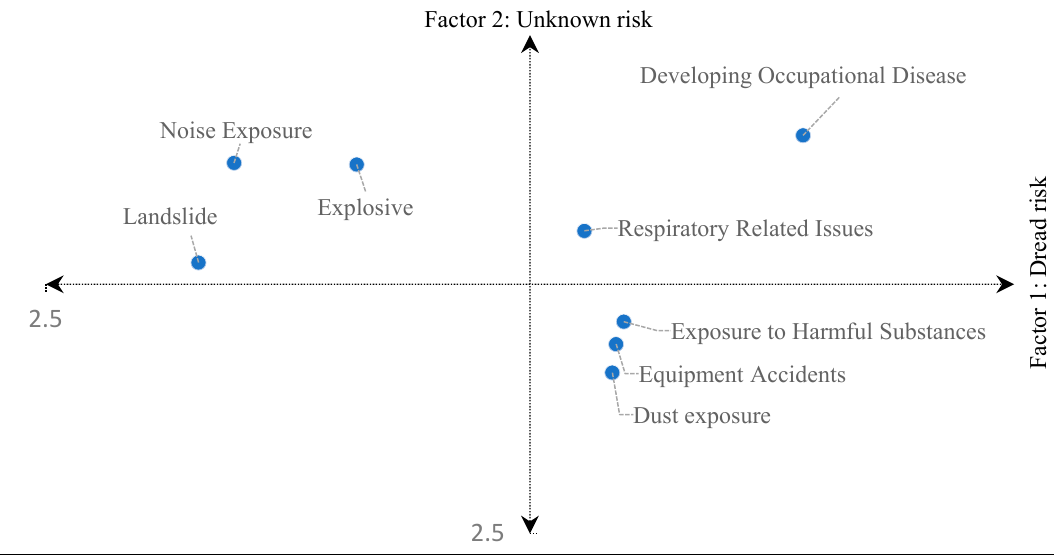
Figure 1. Location of risks in the plane of Principal Components 1 and 2 for the study sample.